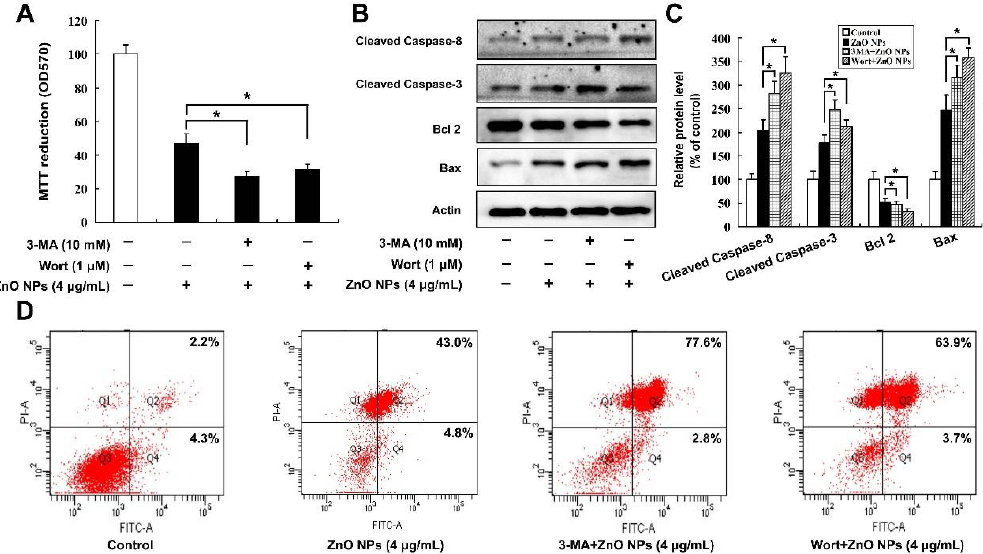
Figure 6. Inhibition of autophagy increases the ZnO NPs-induced apoptosis level in mouse Leydig TM3 cells. Mouse Leydig TM3 cells were treated with 4 µ g / mL ZnO NPs for 24 h in the absence or presence of 10 mM 3-MA or 1 µ M Wortmannin (Wort), then cell viability ( A ), the protein levels of cleaved Caspase-8, cleaved Caspase-3, Bcl 2, and Bax ( B ) and the AnnexinV-FITC positive staining cells ( D ) were tested by MTT assay, Western blot, and flow cytometry, respectively. ( C ) The relative protein levels of cleaved Caspase-8, cleaved Caspase-3, Bcl 2, and Bax were quantified by densitometry. The experiment was done in triplicate and repeated three times. Data were analyzed by one-way ANOVA. * p < 0.05.